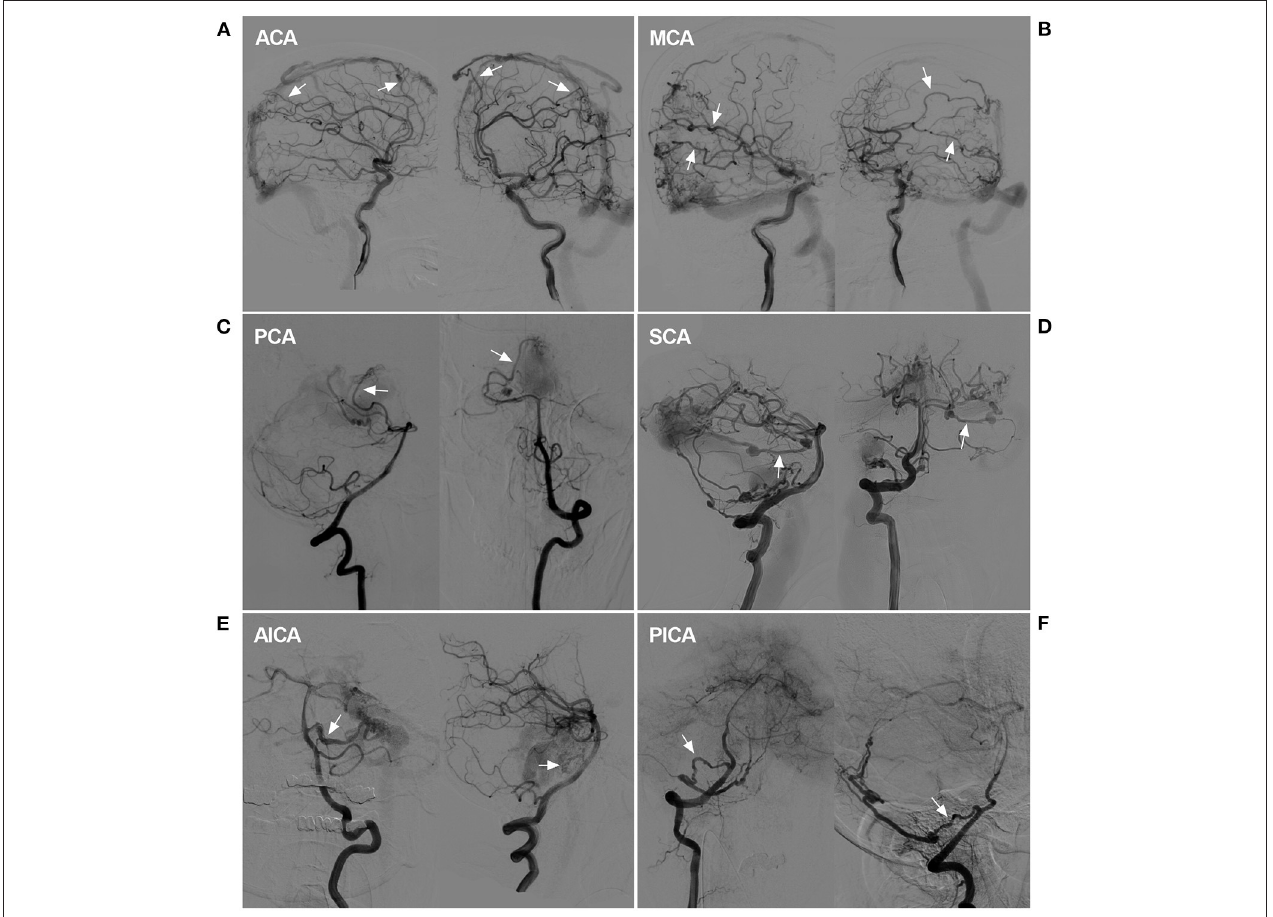
FIGURE 9 | Rare instance of a pial artery serving as the feeder for a DAVF. (A) DSA showed that the ACA sent dural branches (arrows) to supply a SSS DAVF. (B) DSA showed that the MCA sent dural branches (arrows) to supply a SSS DAVF. (C) DSA showed that the PCA (arrows) sent a dural branch to supply a tentorial DAVF. (D) DSA showed that the SCA (arrows) sent a dural branch to supply a TSS DAVF. A flow-related aneurysm may be seen. (E) DSA showed that the AICA (arrows) sent a dural branch to supply a tentorial DAVF. A dissecting aneurysm may be seen. (F) DSA showed that the PICA (arrows) connected to the PMA to supply a tentorial DAVF. ACA, anterior cerebral artery, AICA, anterior inferior cerebellar artery; DAVF, dural arteriovenous fistula; DSA, digital subtraction angiography; MCA, middle cerebral artery, PCA, posterior cerebral artery, PICA, posterior inferior cerebellar artery; PMA, posterior meningeal artery; SCA, superior cerebellar artery; SSS, superior sagittal sinus; TSS, transverse-sigmoid